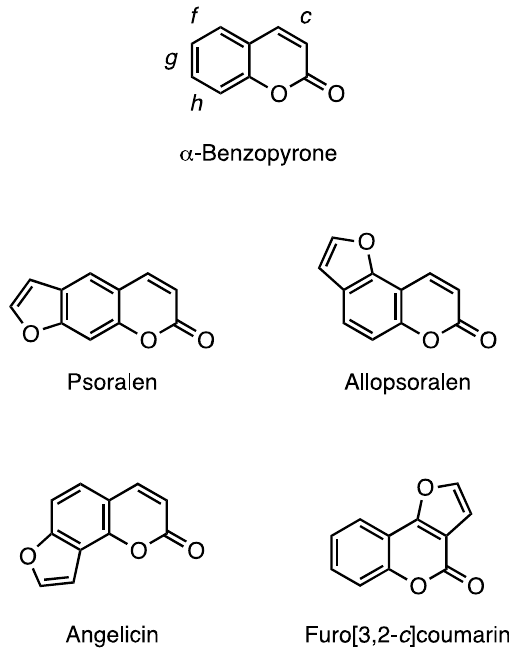
Figure 1. Core structure of the most common naturally occurring furocoumarin derivatives.